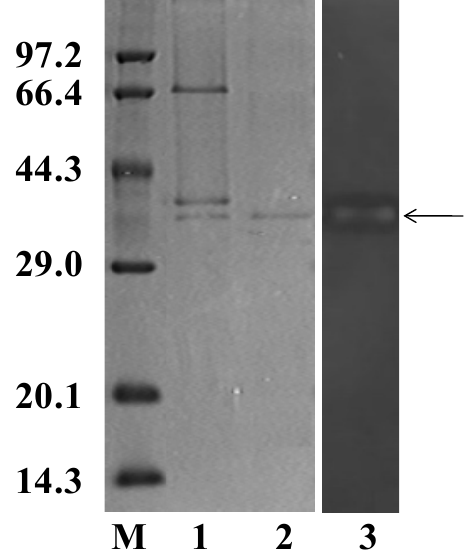
Figure 3. SDS-PAGE pattern and zymography of purified κ-carrageenase. SDS-PAGR was conducted in a 5%/15% discontinuous polyacrylamide gel at 25 mA at room temperature and stained with Coomassie brilliant blue R-250. The peaks from Sephadex G-200 contained three protein bands ( 1 ); Only one protein band, with an apparent molecular mass of 40.8 kDa, was detected in the activity peak from Sephadex G-75 ( 2 ); The sample of the activity peak from Sephadex G-75 was applied to zymography experiment, stained with alcian blue. A degradated band was detected at the same position, just as pointed by the arrow ( 3 ). Line M was protein molecular mass marker.